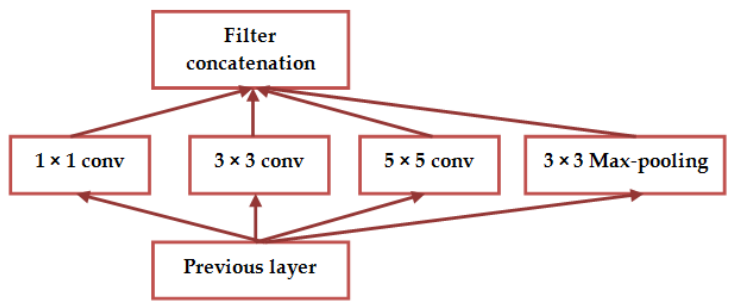
Figure 25. GoogleNet architecture.